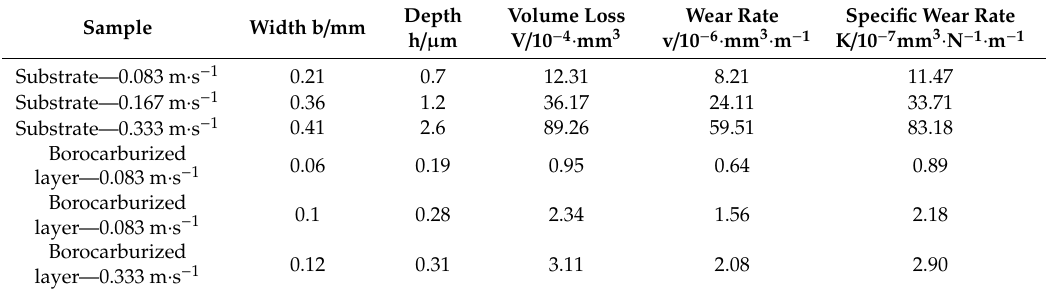
Table 1. Sliding wear results of substrate and borocarburized layer at di ff erent speeds. Sample Width b /